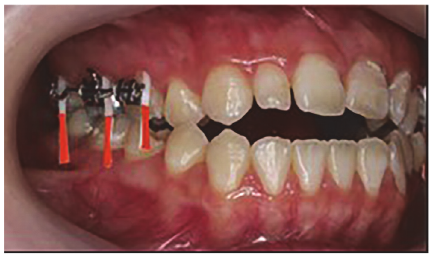
Figure 4: Periopaper strips were placed into the mesiobuccal sulcus for GCF sample